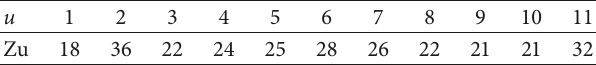
Table 2: Handling station capacity (unit: wagons per